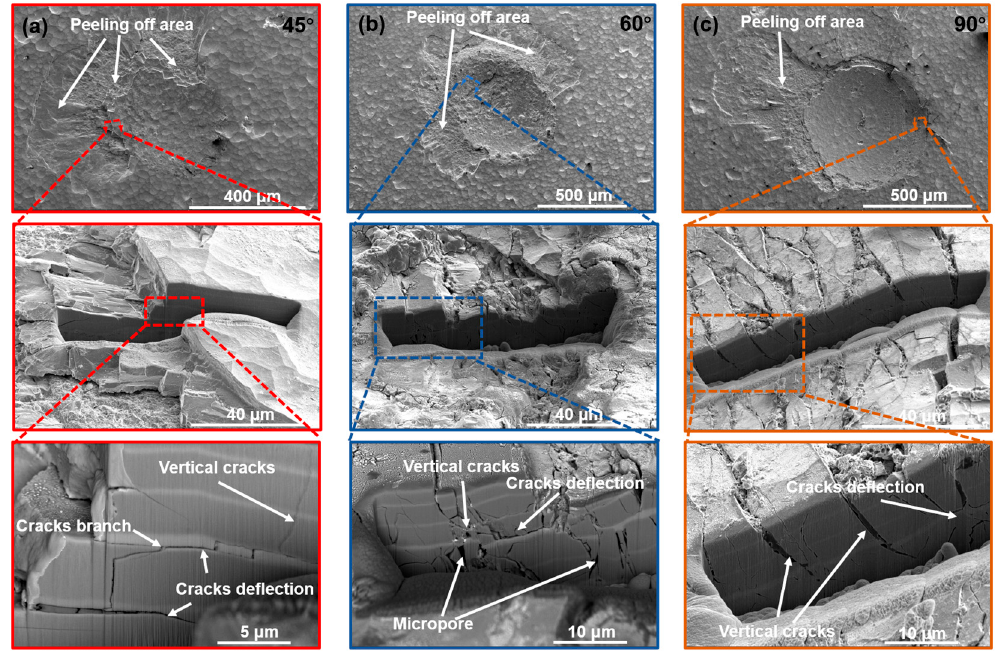
Figure 7. Impact damage morphologies and the sectional images of eroded of TiN / Ti coatings impacted under different angles: ( a ) Impacted under 45°, ( b ) impacted under 60°, and ( c ) impacted under 90°.